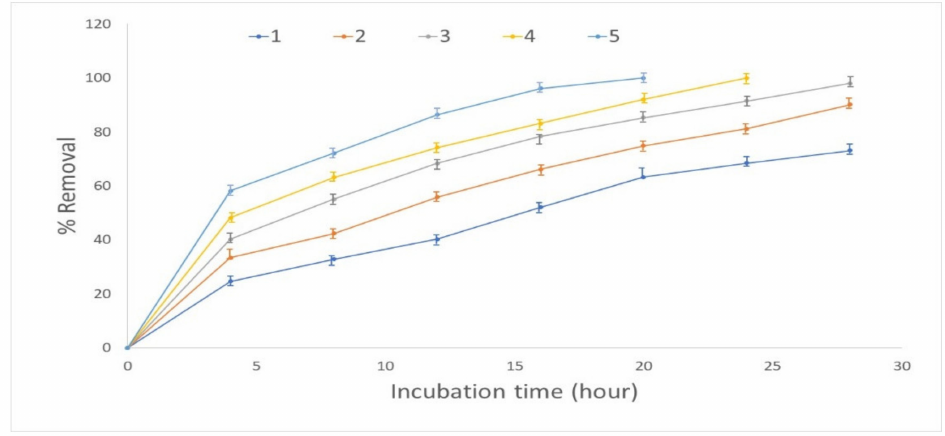
Figure 5. Effect of E. crassipes biomass (g/L) on the removal of 100 cobalt (II). pH 5.0. 28 ◦ C. 100